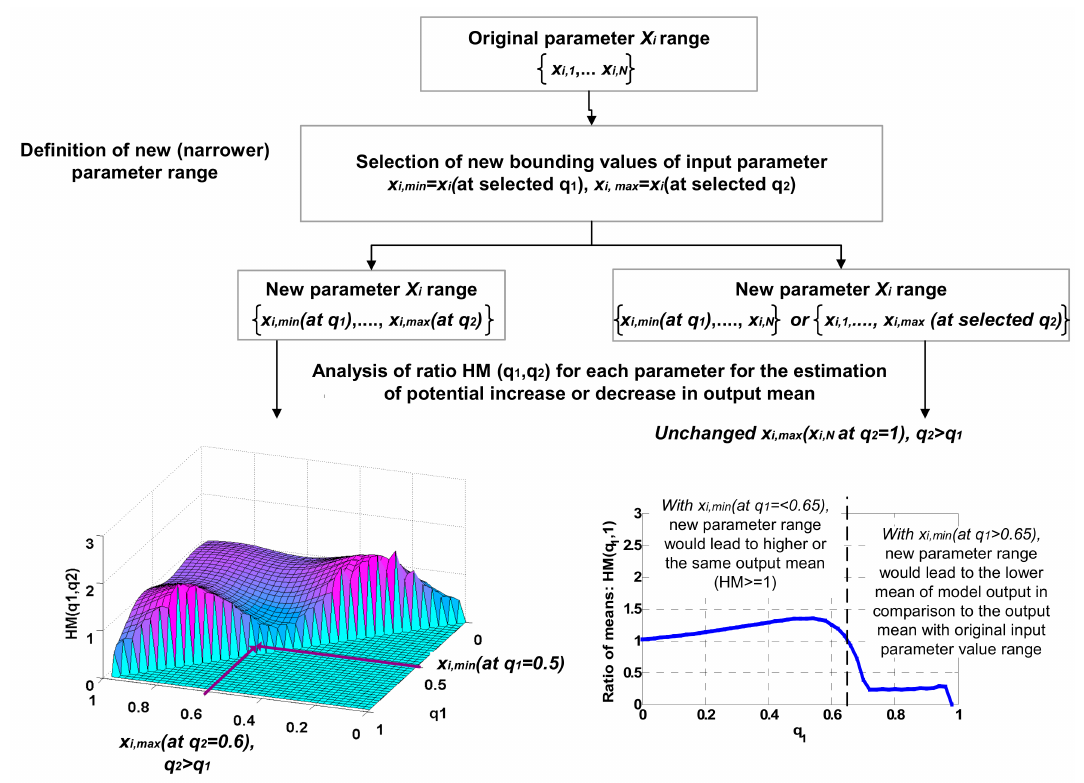
Figure 6. Scheme for the exploration of the e ff ect of the uncertainty reduction on model output using ratios HM, HV for each